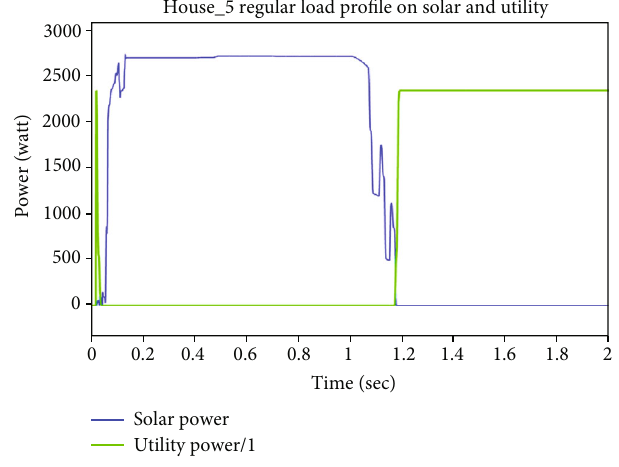
Figure 39: Regular load pro fi le of house 5.